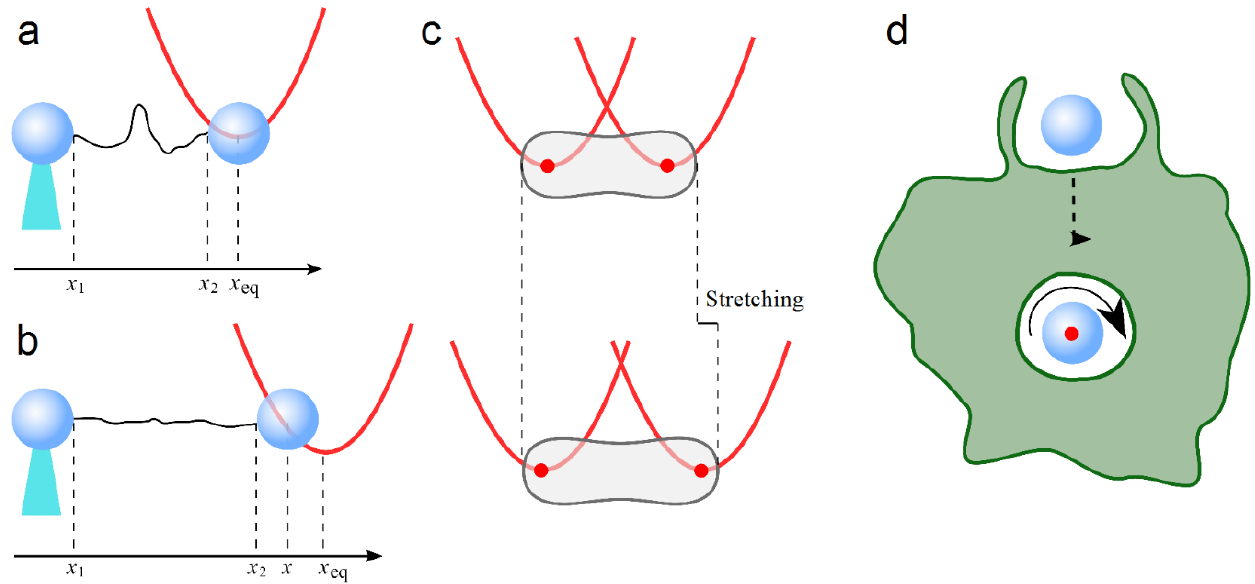
(cid:1) (cid:0) x − x eq